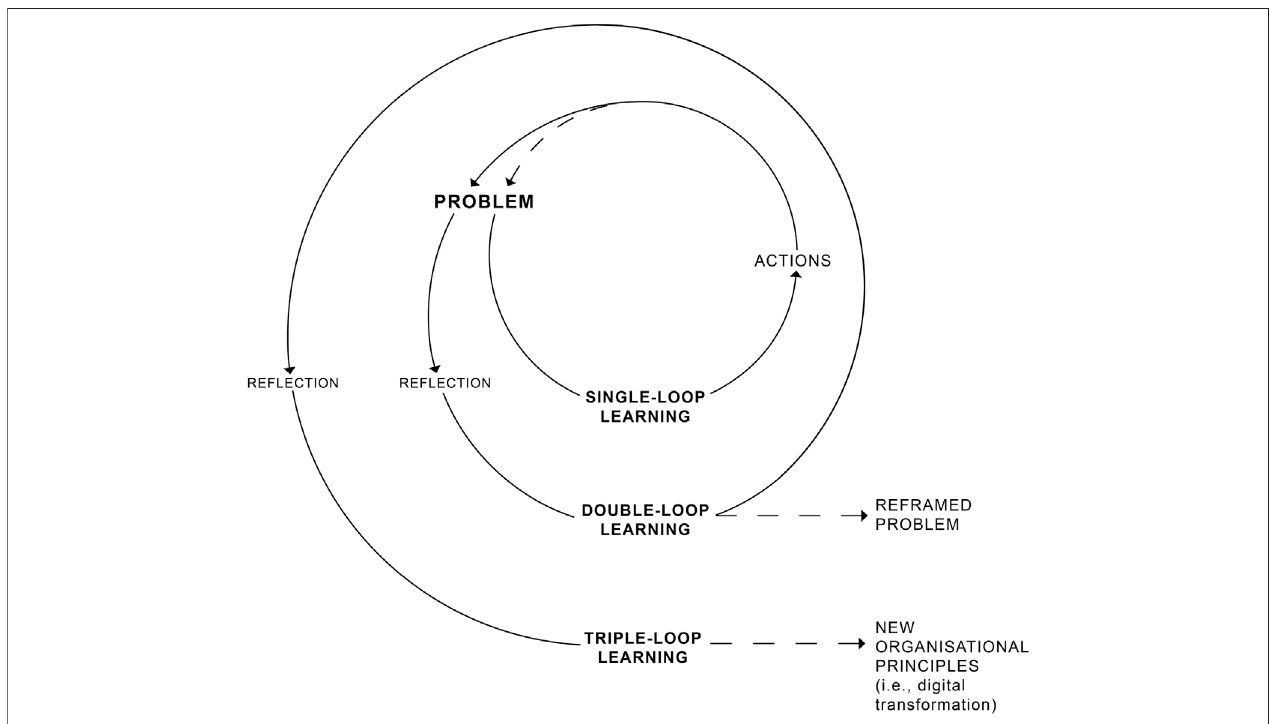
FIGURE 1 | Organizational learning loop